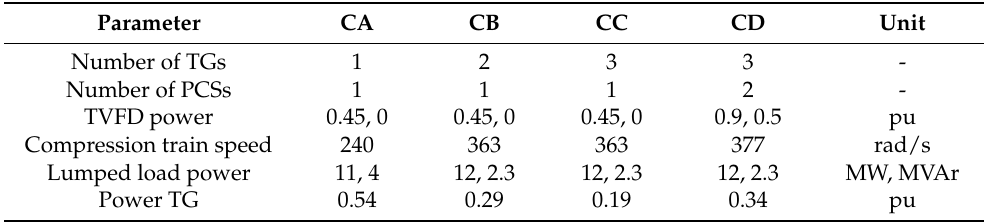
Table 4. LNG plant configurations.